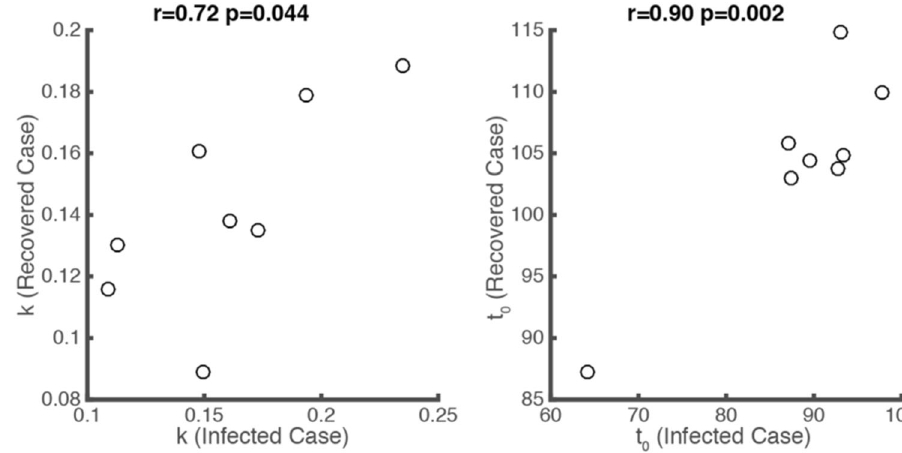
Fig. 7 Relationship between the rules for infected and recovered COVID-19 cases in eight selected countries